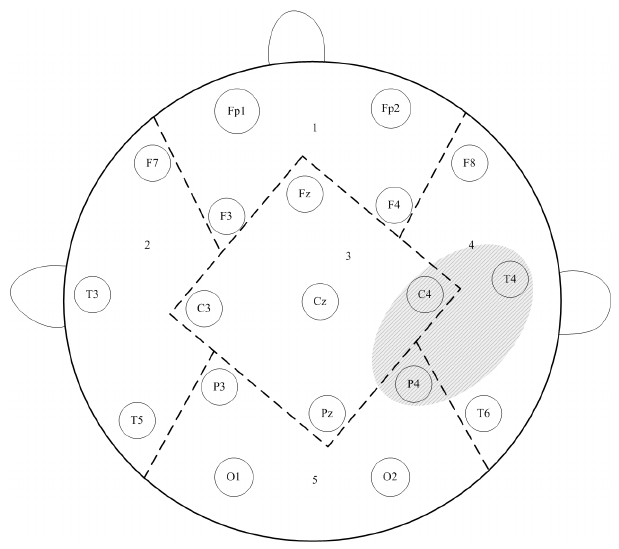
Fig. 5. Diagrammatic sketch of EEG zones. \1, 2, 3, 4 and 5" correspond to frontal, left-temporal central, right-temporal and occipital region, respectively. Gray scale indicated salient brain